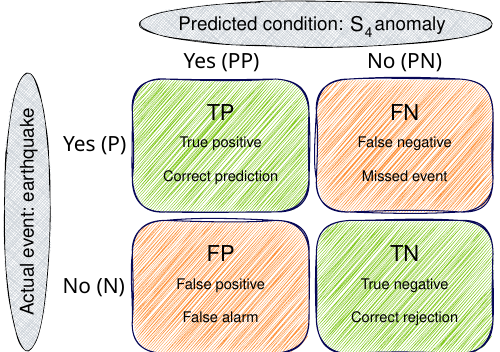
Figure 7. Confusion matrix